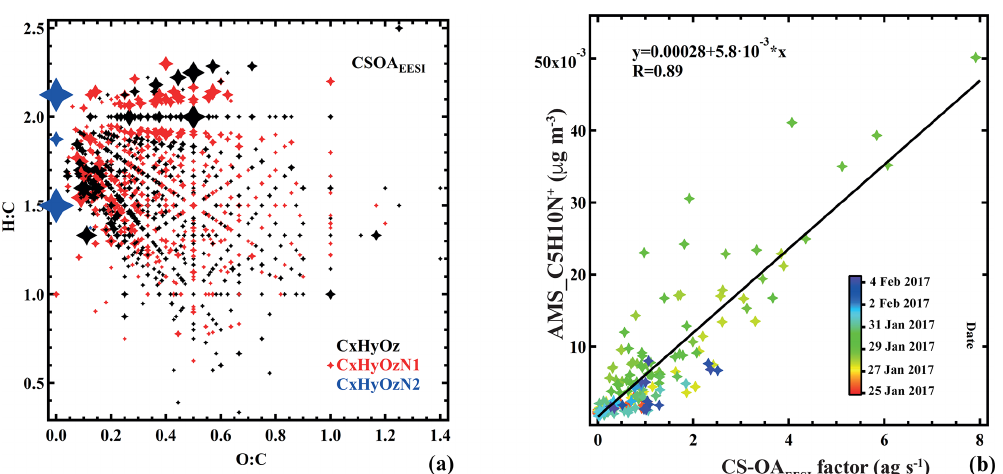
Figure 5. (a) Van Krevelen plot (atomic H : C vs. O : C ratio) of the cigarette smoking (CS-OA EESI ) factor mass spectrum. Points are sized by the fraction of each neutral compound apportioned to CS-OA EESI . Colors denote C x H y O z , C x H y N 1 O z , and C x H y N 2 O z groups. (b) Comparison of CS-OA EESI and C 5 H 10 N + , colored by AMS